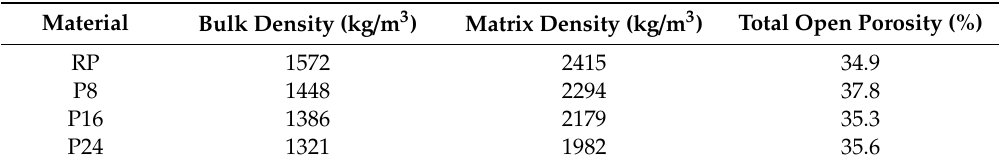
Table 2. Basic physical